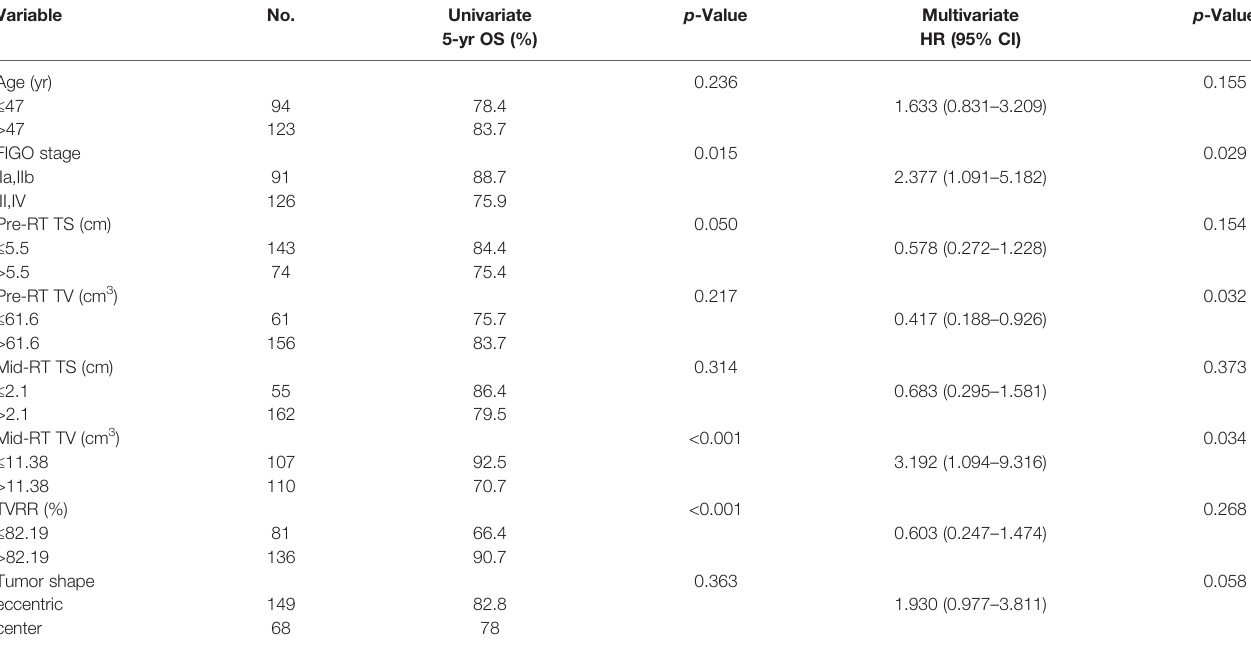
TABLE 4 | Prognostic analysis of overall survival. Variable